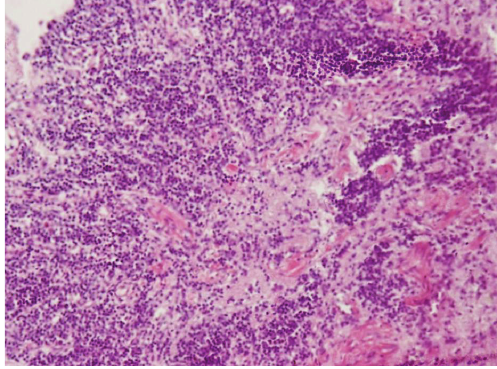
Figure 2: Microscopic appearance of heart shows evidence of myo- carditis.